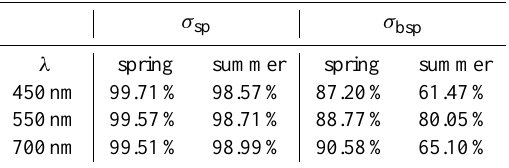
Wiedensohler et al. (2010), the uncertainty of D p, TDMPS is estimated to be 3.5 %, and the uncertainties of N TDMPS are estimated at 30 %, 10 % and 25 % for the size of 3–20